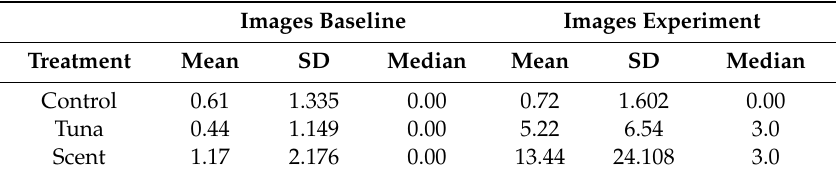
Table 2. Mean number of images per site (within the 5-day period) in two di ff erent treatments (tuna, scent) and the control sites during baseline and the experimental period.